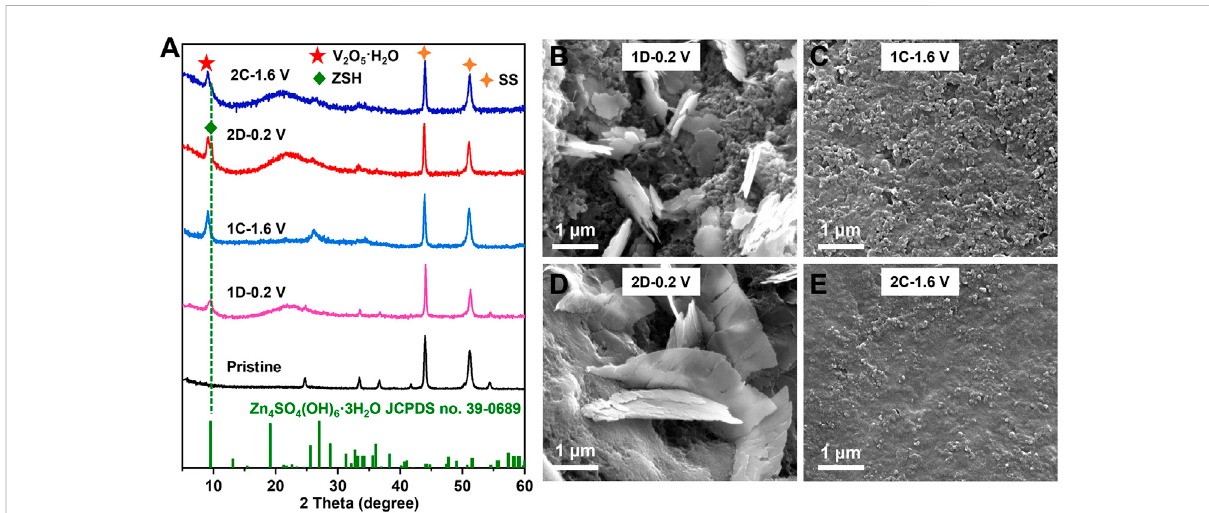
FIGURE 4 (A) XRD patterns of the V fi rst or second cycle (1D-0.2 V; 2D-0.2 V), charged 2 O 3 @C cathode at pristine state (Pristine), discharged state in the state in the fi rst cycle or second cycle (1C-1.6V; 2C-1.6 V) in aqueous ZnSO 4 solution at 0.5 A g − 1 . SEM images of the V 2 O 3 @C cathode at (B) dischargedstateatthe fi rstcycle(1D-0.2 V), (C) chargedstateinthe fi rstcycle(1C-1.6 V), (D) discharged stateinthesecond cycle(2D-0.2 V),and (E) charged state in the second cycle (2C-1.6 V), in aqueous ZnSO 4 solution at 0.5 A g − 1